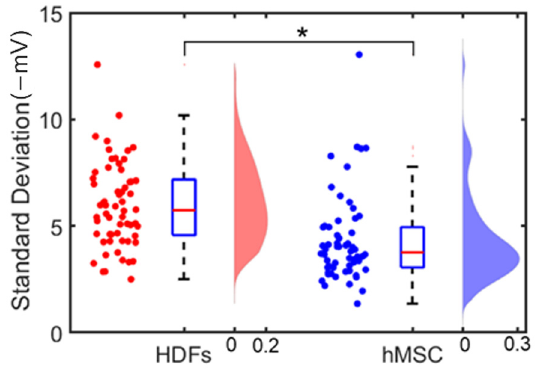
Figure 9. The standard deviations calculated from the surface potential distribution of single cells. Sixty independent cells of each cell type were analyzed. Two cell types were analyzed: HDFs (red) and hMSC (blue). (Left) the scattered plot of the standard deviations from single cells’ surface potential distribution; (center) the boxplot of the standard deviation from single cells’ surface potential distribution; (right) the histogram of the standard deviation from cells’ surface potential distribution. * represents p < 0.05 (for n = 60), which indicates a significant difference between the two groups of cells .